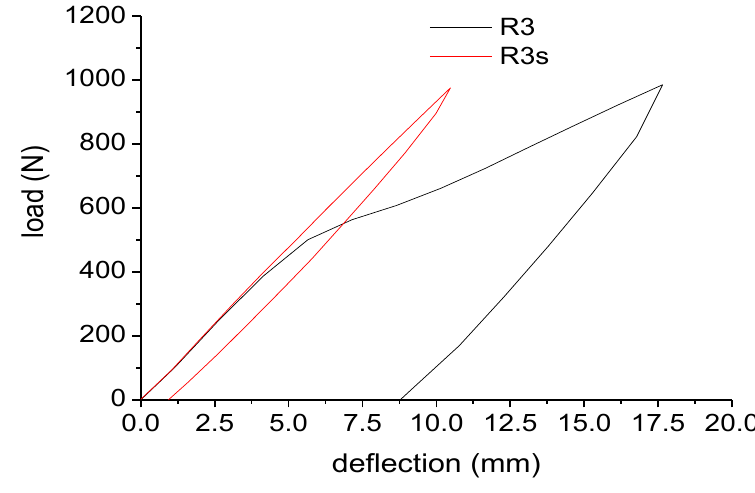
Figure 11. Cyclic loading tests for plastic lumber